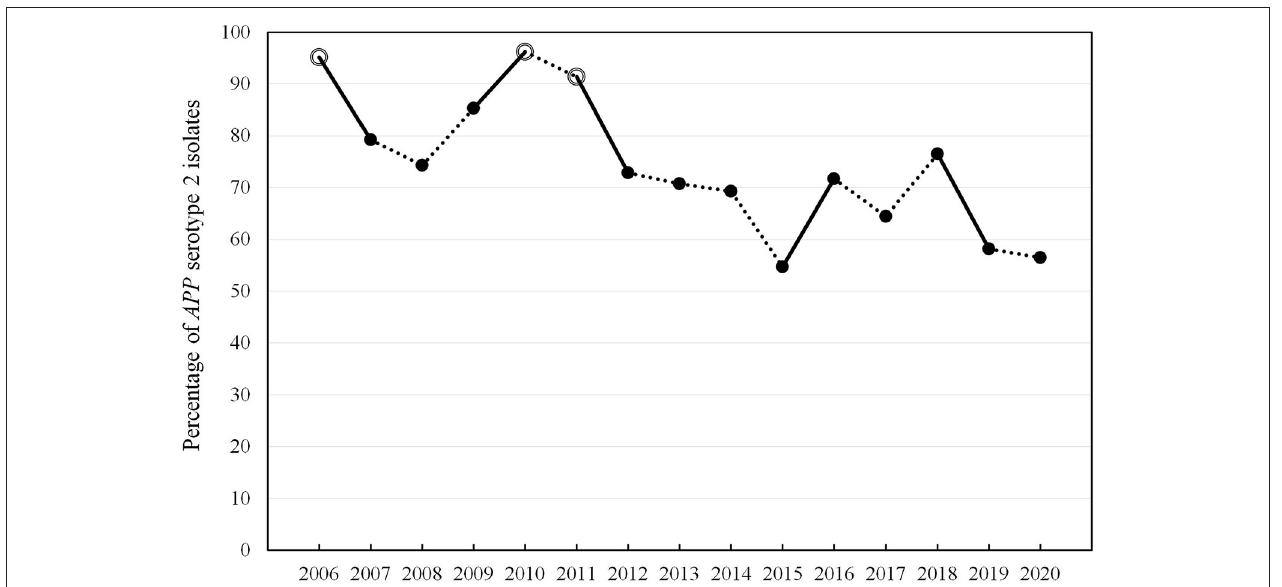
FIGURE 1 | Percentage of APP serotype 2 isolates in the years 2006–2020 determined by slide agglutination with specific rabbit antisera (strict lines show statistical significant changes from 1 year to the next, white dots indicate no significant changes to the initial year 2006, while black dots indicate significant changes compared to 2006 with p < 0.05 in Wald test via linear logistic